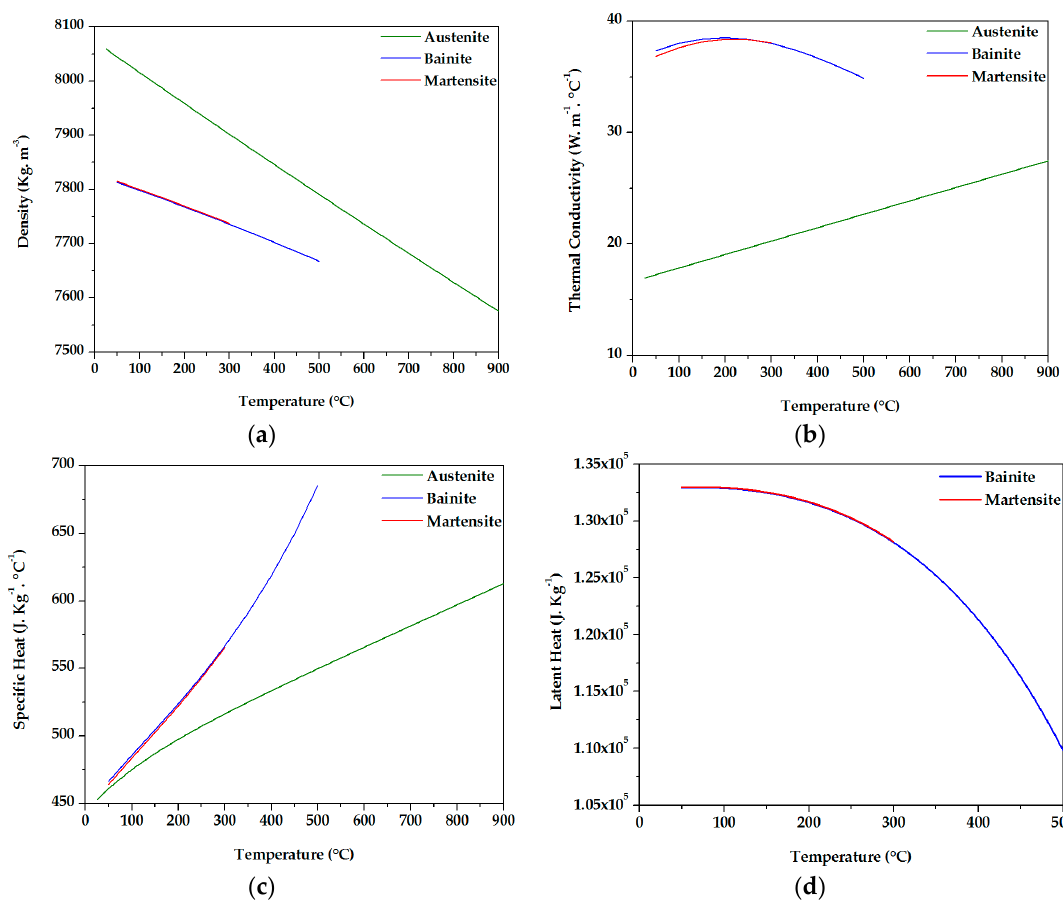
Figure A1. ( a ) Density of austenite, bainite and martensite phases; ( b ) Thermal conductivity of austenite, bainite and martensite phases; ( c ) Specific heat of austenite, bainite and martensite phases; ( d ) Latent heat of bainite and martensite phases.